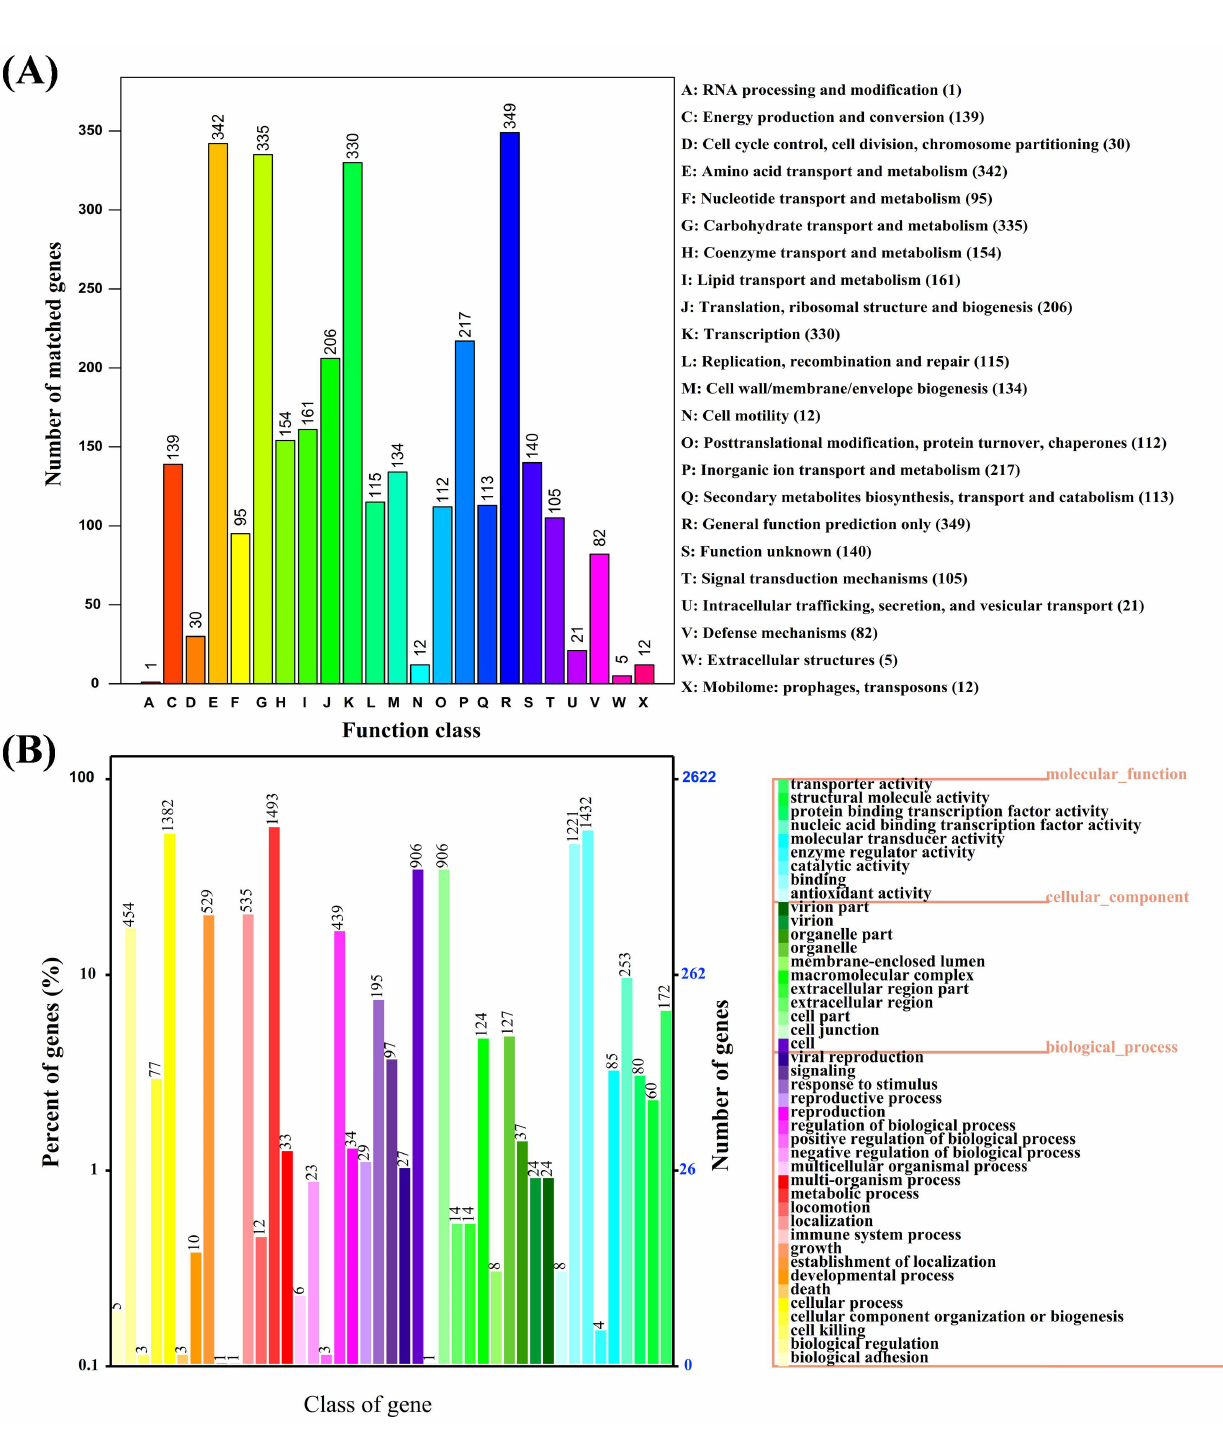
Figure 3. Functional annotation of strain MZT7. ( A ) COG function classification. ( B ) GO